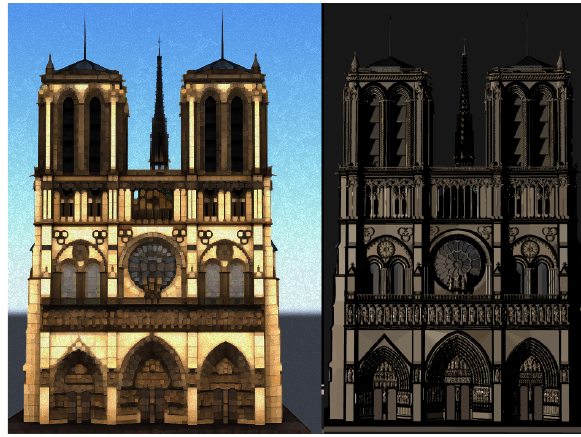
Figure 1. The two NPR styles used in the study: watercolor (left) and technical illustration